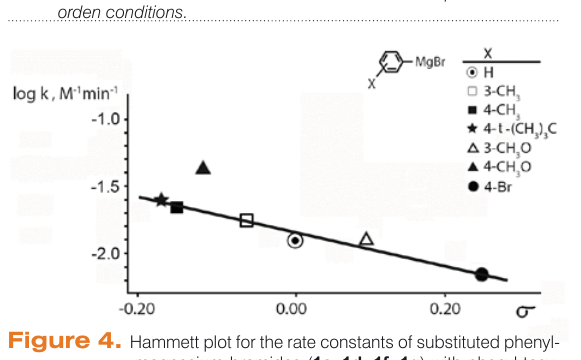
Figure 4. Hammett plot for the rate constants of substituted phenyl- magnesium bromides ( 1a–1d, 1f, 1g ) with phenyl tosy- late ( 2 ) in THF:toluene (7:10) at